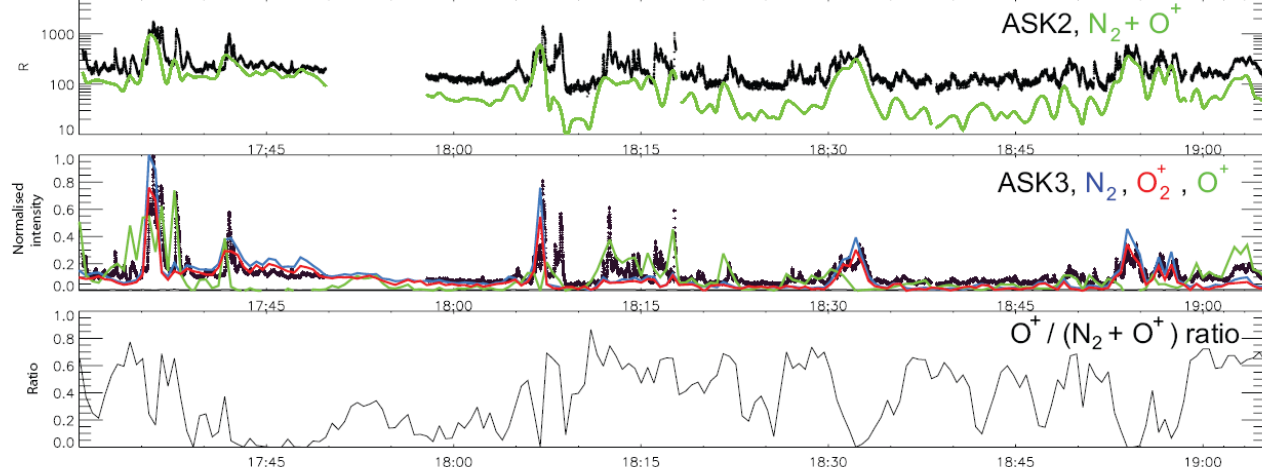
Fig. 3. Comparison of emissions in ASK and SIF for the interval 17:30UT to 19:00UT on 26 January 2006. Panel 1: Emission detected in the centre of ASK2 (black) and the sum of O + and N 2 emissions in SIF O + (7319) (green). Panel 2: Normalized intensities of O + (green) and N 2 (blue) from SIF spectra from O + (7319), intensity of O detected in ASK3 (black) and O + (red). Panel 3: Ratio of O + /(N 2 + O + ) illustrates when emissions in ASK2 were caused mainly by O + emission rather than the contaminant N 2 1PG